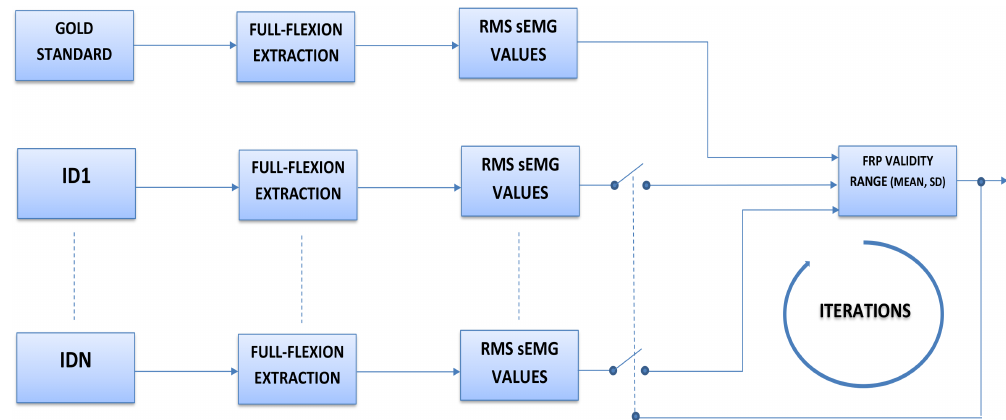
Figure 8. Block diagram. The switch symbolizes the selection of the RMS values within the validity